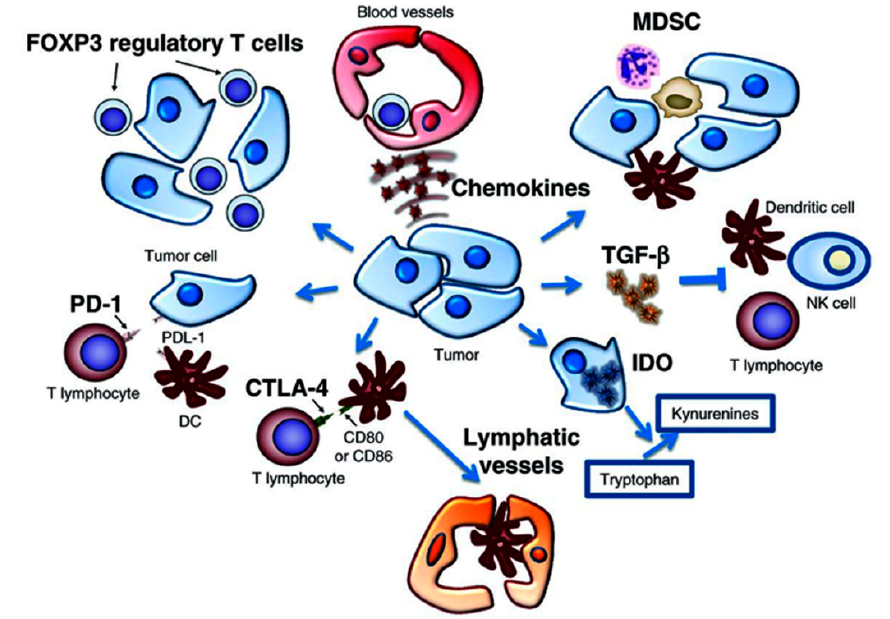
Figure1. Thebiologicalcellularandmolecularinteractionswithinthecomplextumormicroenvironment. Figure 1. The biological cellular and molecular interactions within the complex tumor Solid tumor cells interact with a variety of cells and molecules, including lymphocytes, cytokines, microenvironment. Solid tumor cells interact with a variety of cells and molecules, including chemokines, dendritic cells, and T cells, among others. The cells and molecules which create this lymphocytes, cytokines, chemokines, dendritic cells, and T cells, among others. The cells and tumor microenvironment can serve as excellent immunomarkers for various cancer immunotherapy molecules which create this tumor microenvironment can serve as excellent immunomarkers for applications. Reproduced from [7], with permission from the American Association for Cancer various cancer immunotherapy applications. Reproduced from [7], with permission from the Research, American Association for Cancer Research, 2012.